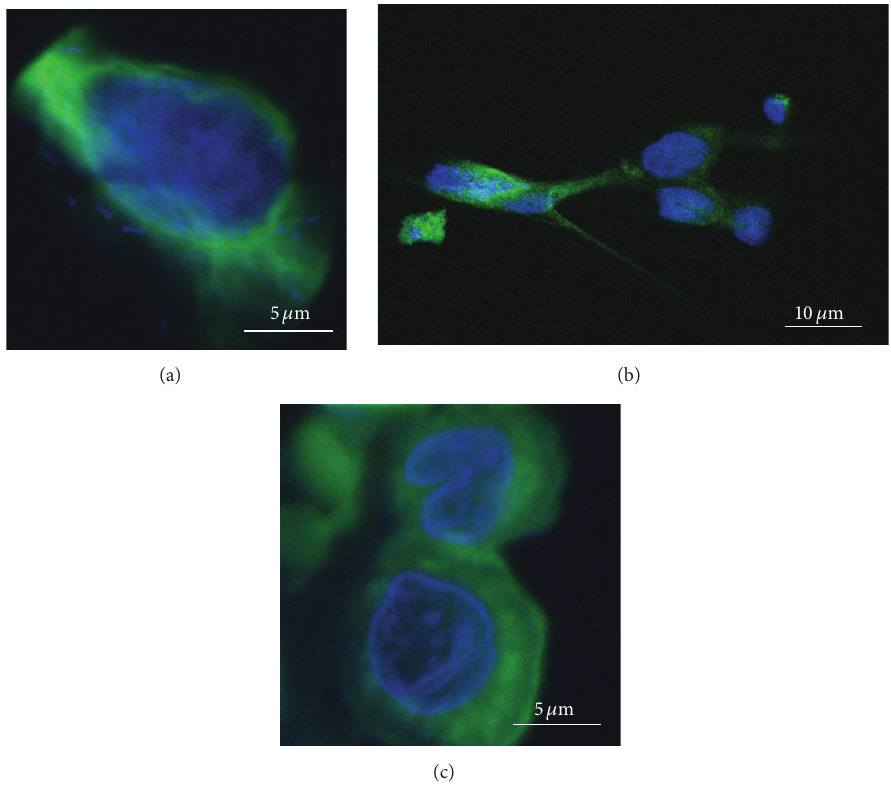
Figure 2: Confocal fluorescence microscopy (a–c) of representative cells located in the cambium layer and stained for markers of the osteoblast lineage. Nuclei were stained with DAPI (blue). (a) Stromal cells stained positive for vimentin (green). (b) Stromal stem cells stained positive for Stro-1(green). (c) Cells of the osteoblast lineage stained positive for Cbfa-1/Runx2 (green).